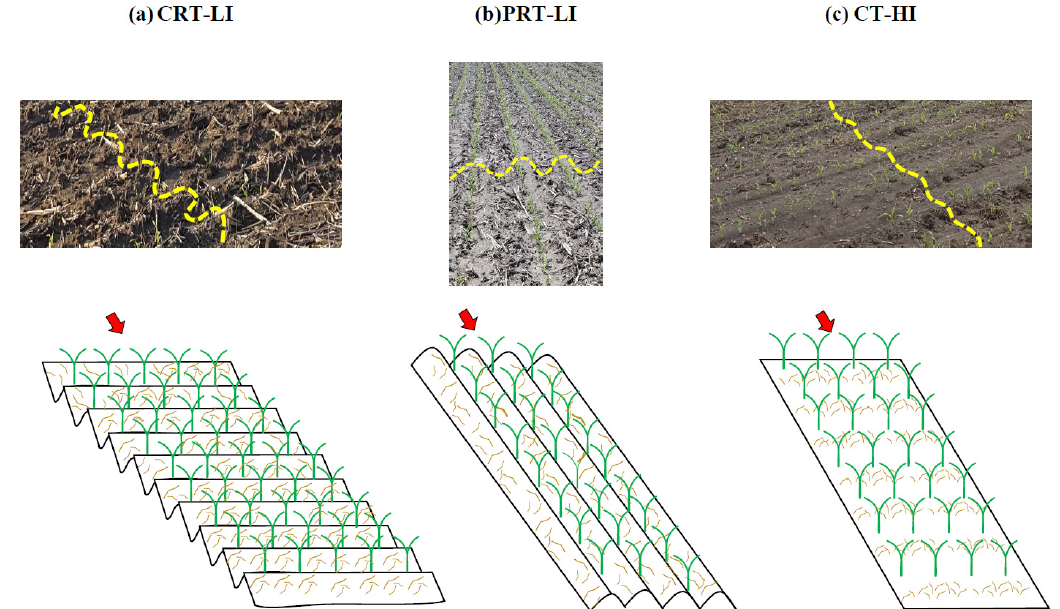
Figure 3. Field pictures and conceptual sketches of the flow pathways sampled in the study sites: ( a ) Contour Ridge Tillage-Low Intensity (CRT-LI), a spring-till corn, ridge-till corn, no-till soybean low-intensity tillage system, where rows were oriented perpendicular to the downslope flow pathway (shown as red arrow); ( b ) Parallel Ridge Tillage-Low Intensity (PRT-LI), a spring-till corn, ridge-till corn, no-till soybean low-intensity tillage system, where rows were oriented parallel to the downslope flow pathway; and ( c ) Contour Tillage-High Intensity (CT-HI), a spring-till corn, fall-till soybean high-intensity tillage system, where strip rows were oriented perpendicular to the downslope flow pathway. The yellow dashed lines in the field pictures represent the oriented roughness pattern.